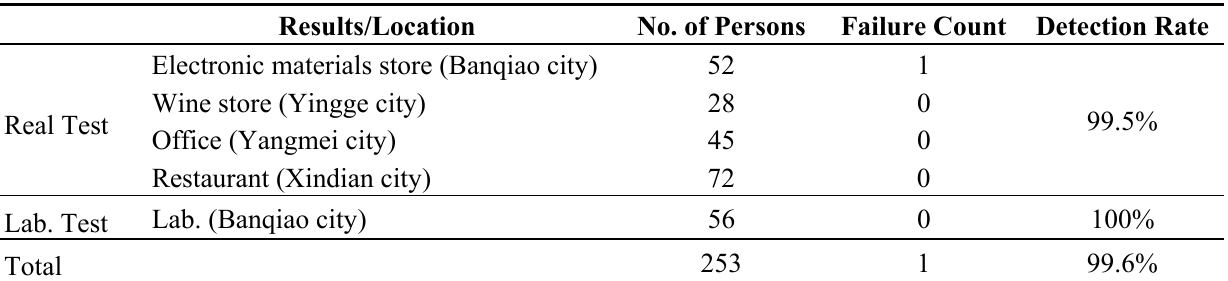
Table 1. The Experimental Results of False